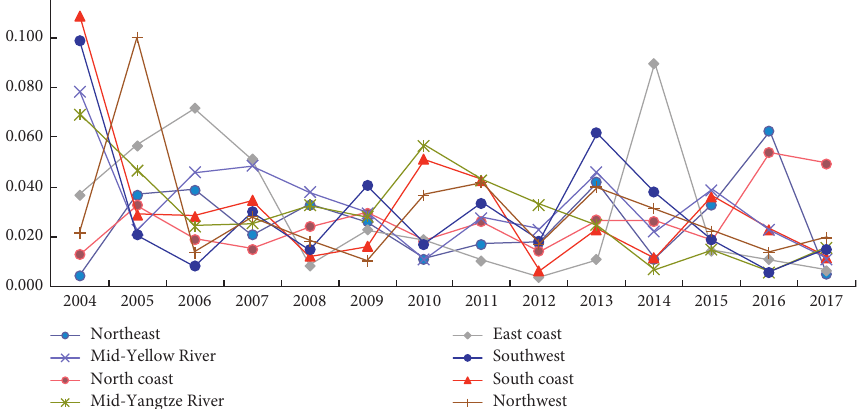
Figure 2: Variation trend of regional differences in green TFP of logistics industry in the eight economic